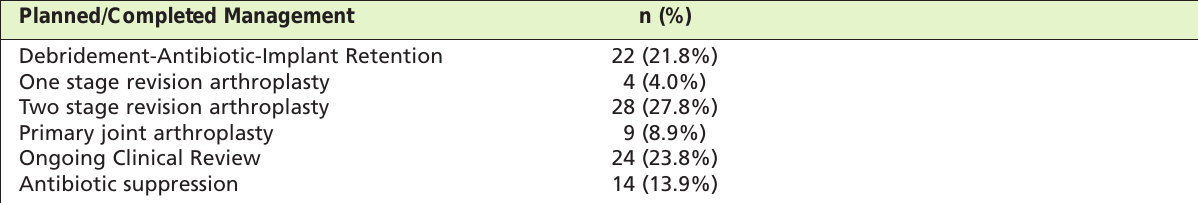
Planned/Completed Management of patients presenting to PJI MTD meeting Table III: